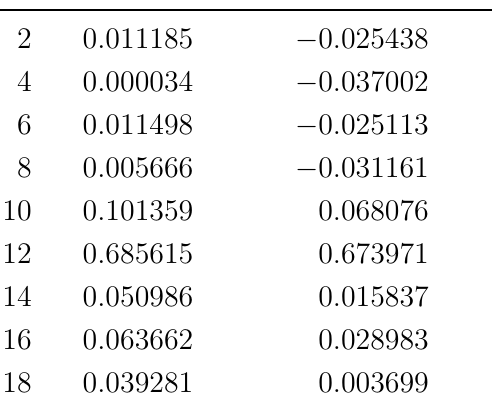
Table 2. Coefficient of determination in linear regression analysis method applied to all antibodies and enzyme denoted by numbers in Figure